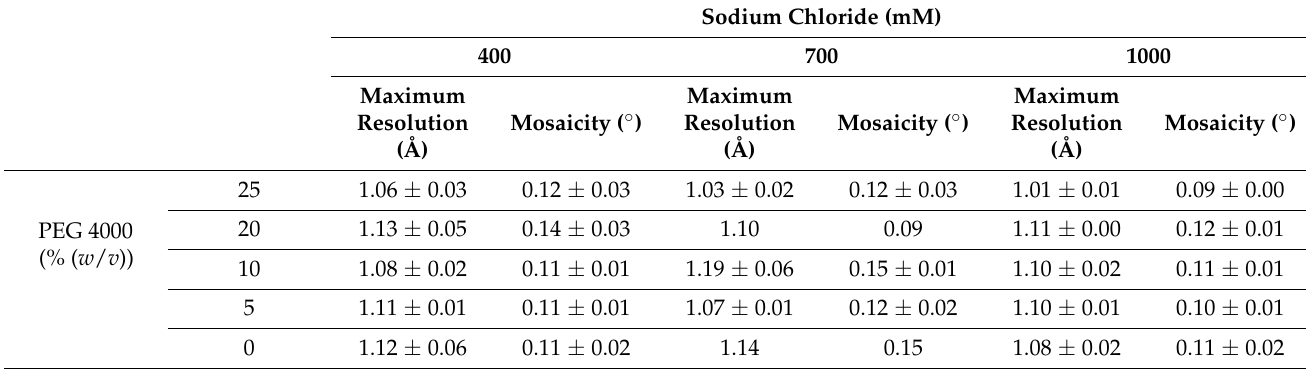
Table 2. Maximum resolution of lysozyme crystals grown in various concentrations of sodium chloride and PEG 4000 by the microbatch method. The X-ray diffraction data (maximum resolution (Å) and mosaicity ( ◦ )) were obtained at the Diamond Light Source i04-1. The data were processed using the autoProc pipeline. Most of the experiments were performed at least in duplicate, except for the single case shown without the standard deviation.